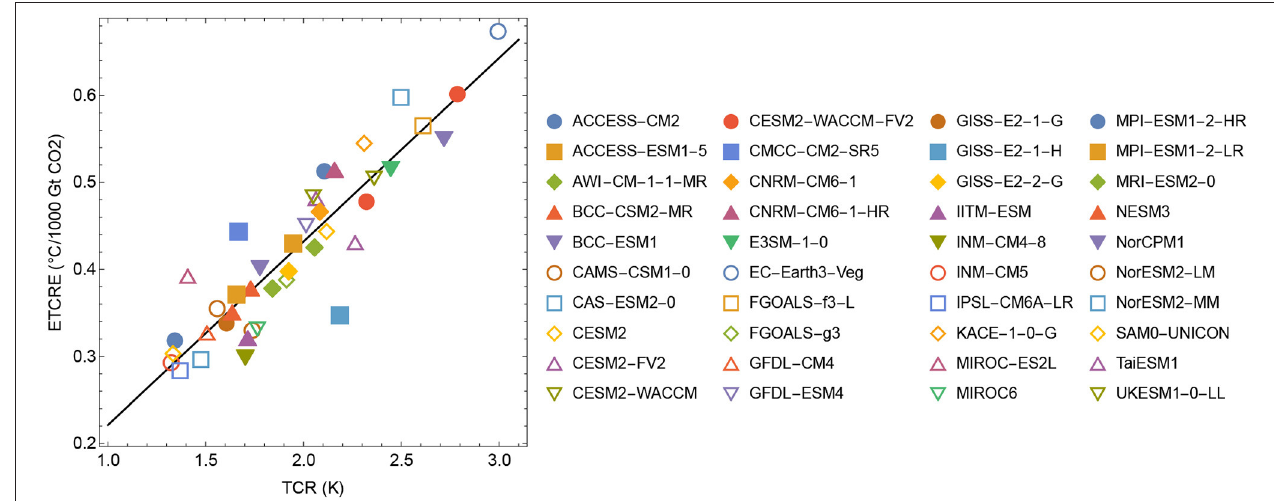
FIGURE 8 | The approximately linear relationship between the estimated ETCRE and TCR of the CMIP6 model used to inform the temperature response